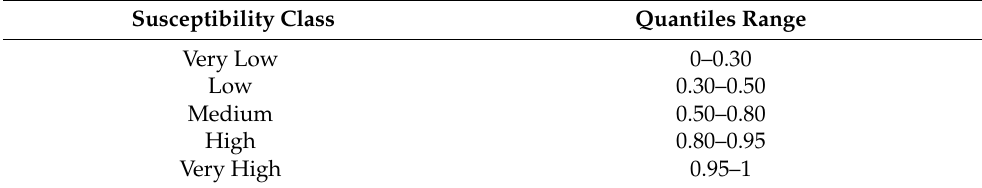
Table 2. Susceptibility classes based on quantile